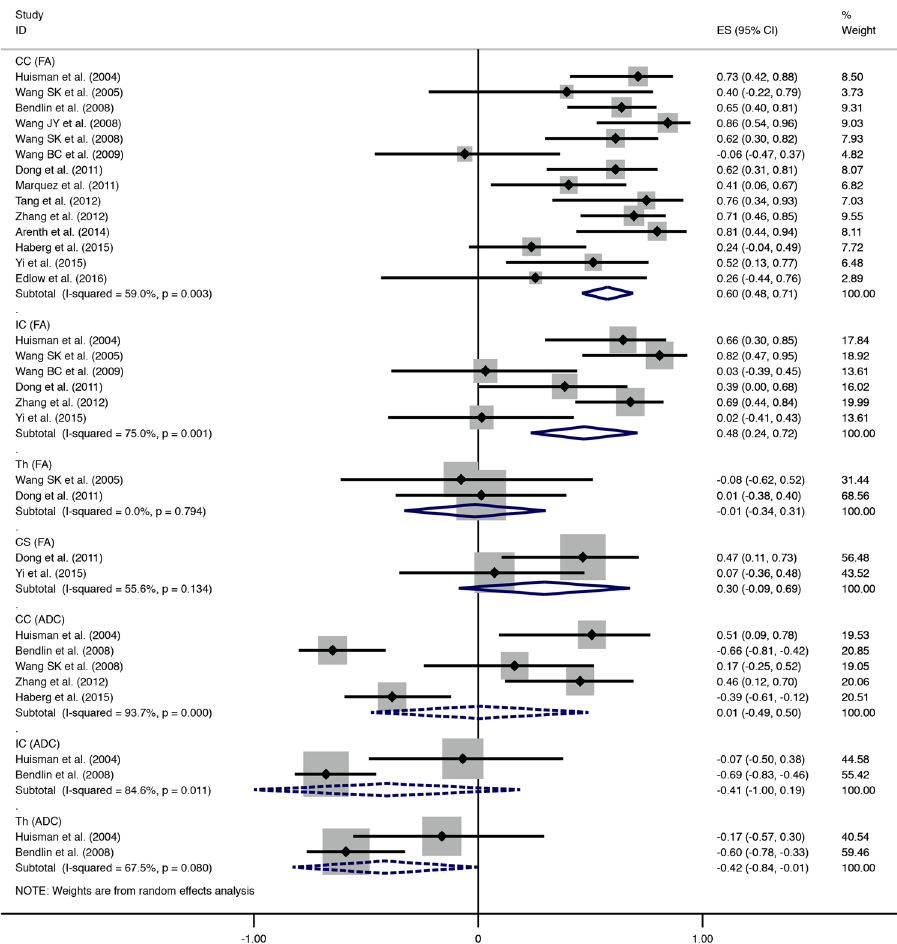
Figure 3. Summary forest plot comparing the FA/ADC-consciousness correlations of different brain regions from ROI studies. Solid-line diamonds represent overall r value of FA-consciousness correlations, and dotted diamonds are for ADC-consciousness correlations. FA, fractional anisotropy; ADC, apparent diffusion coefficient; CI, confidence interval; CC, corpus callosum; IC, internal capsule; Th, thalamus; CS, centrum